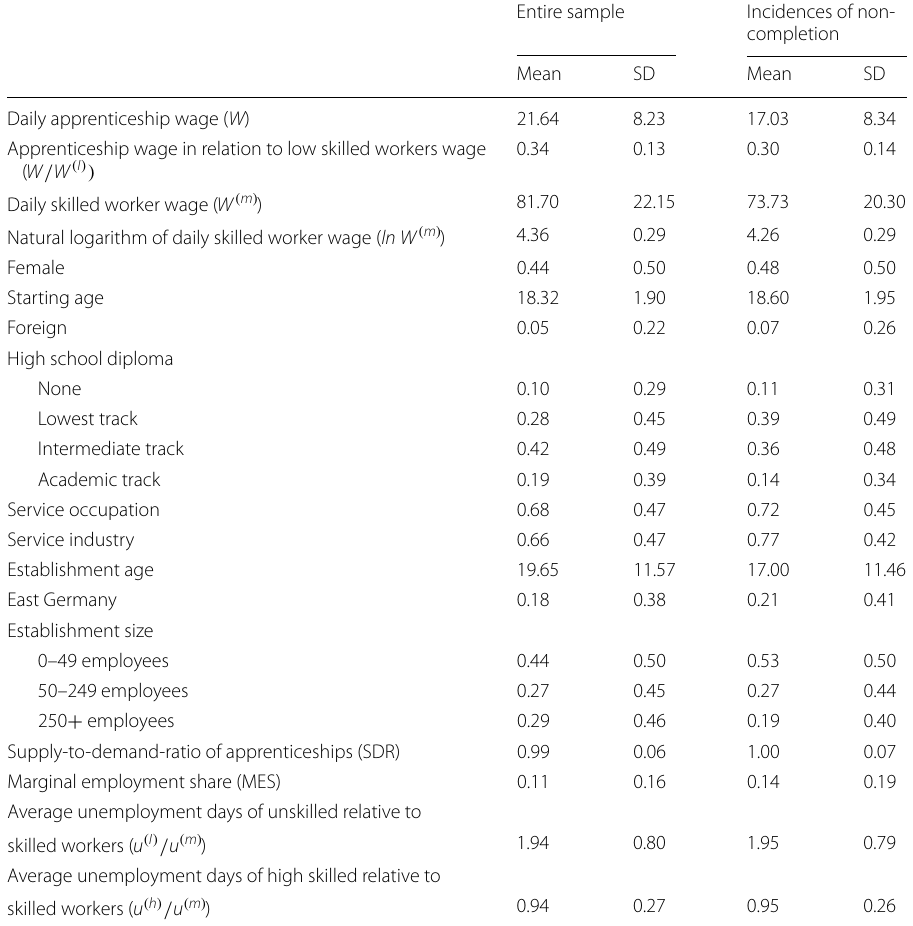
Table 2 Descriptive statistics by non‑completion. Source: SIAB 2000‑2013. N observations, n 94,223 apprenticeships, f =